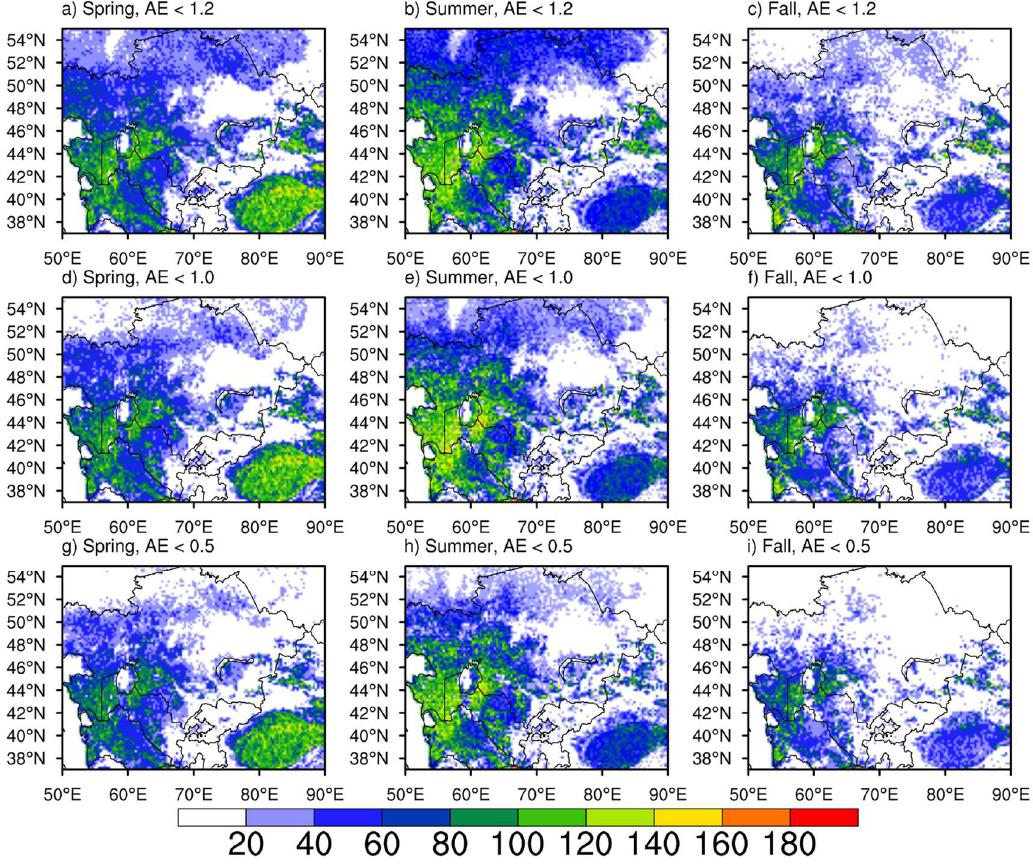
Figure 9. Spatial distributions of the dust occurrence number during the 2000–2016 period in the spring ( a , d , g ), summer ( b , e , h ), and fall ( c , f , i ) seasons with different Angstrom exponents as the threshold: ( a – c ) AEt = 1.2; ( d – f ) AEt = 1.0; and ( g – i ) AEt = 0.5.